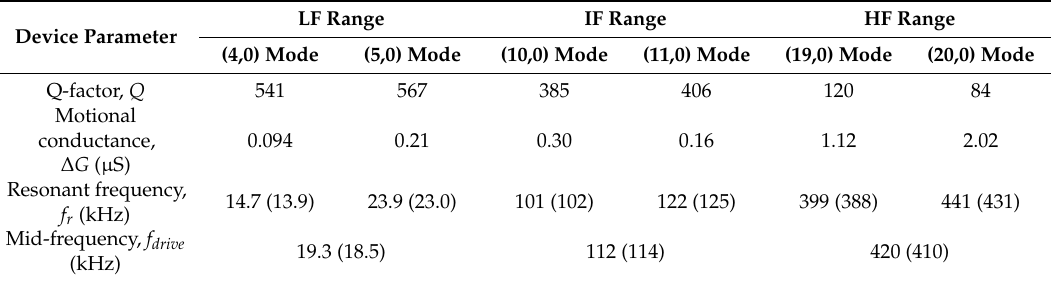
Figure 6. Measured conductance of three different fabricated devices: ( a ) LF, ( b ) IF and ( c ) HF. Modal identification was deduced from laser Doppler vibrometer by accounting for the number of nodal lines. The dashed vertical line indicates the driving frequency. Table 4. Device parameters calculated from the electrical impedance measurements: resonant frequency, quality factor and electrical conductance. The mid-frequency of each working range, calculated from the measured resonant frequencies is also indicated. Simulated frequencies from Figure 2 are given in